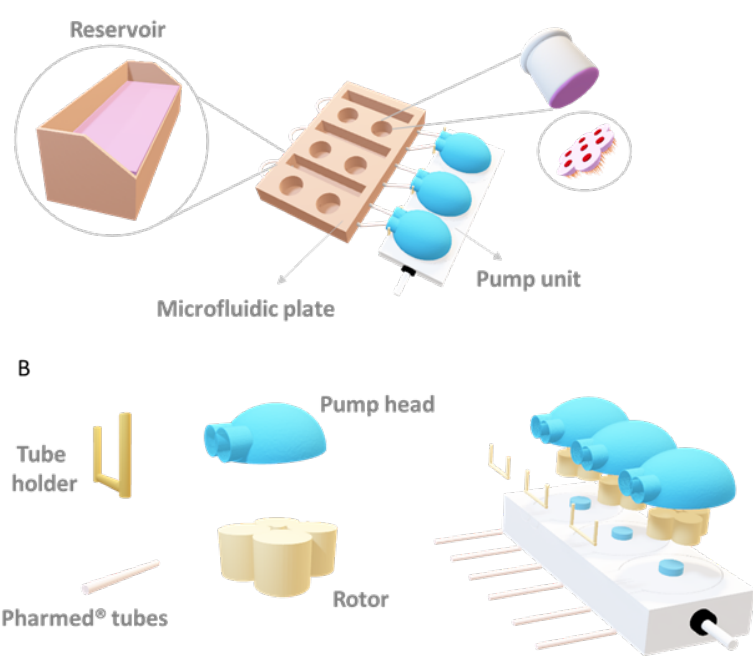
Figure 2. Schematic representation of the Vitrofluid system: ( A ) The Vitrofluid system consists of a pump unit with 3 pump heads connected to a microfluidic plate containing 3 reservoirs and 6 wells suitable for 24 well-plate Transwells. ( B ) Each pump head is composed of the cassette, rotor, PharMed tube, and tube holder. The flow used in these experiments (150 µL/min) led to an estimated FSS of 4.2 × 10 −4 dyne/cm 2 , considered low flow conditions (see simulation Supplementary Figure S1).